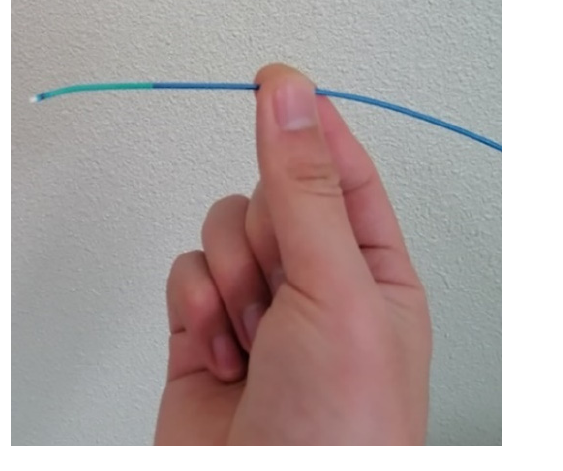
Figure 3. Schematic diagram of force feedback generation.